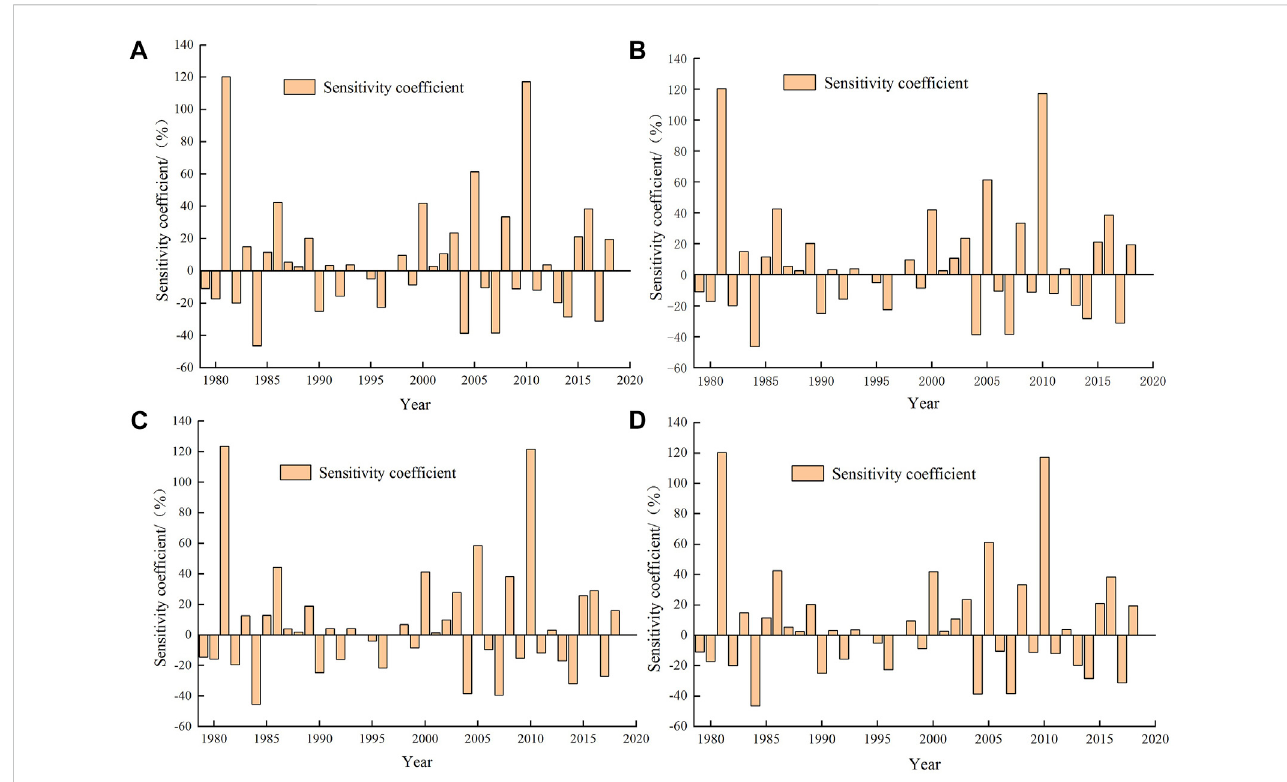
FIGURE 7 Annual variation characteristics of the sensitivity coef fi cients of the four sections. (A) Niya Reservoir. (B) 818 Canal. (C) Niya Station. (D) Niya Canal.